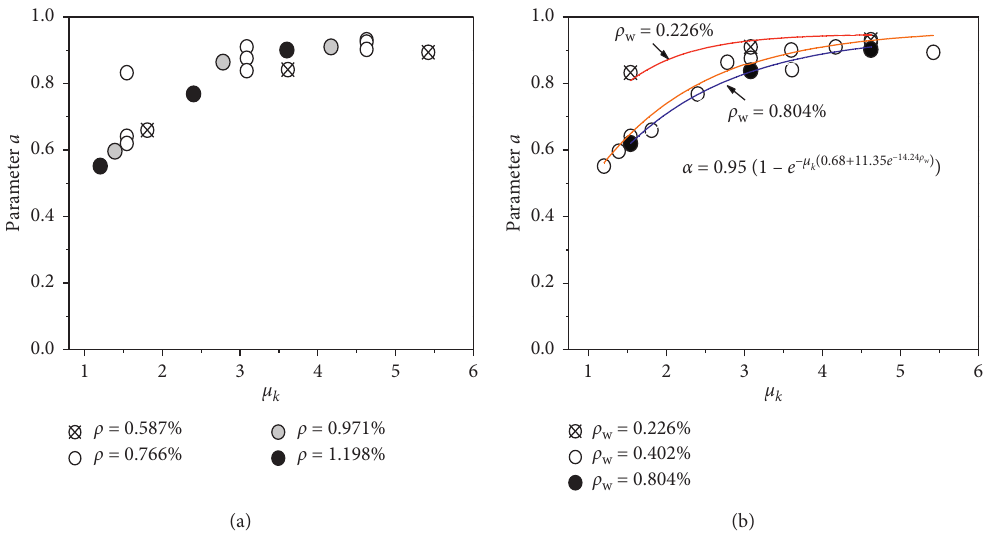
Figure 8: Relationship between μ k and parameter α . (a) Different symbols represent the difference in ρ . (b) Different symbols represent the difference in ρ w .